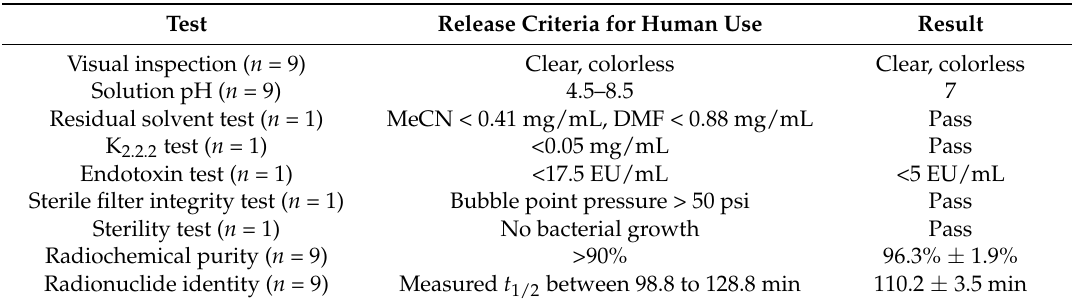
Table 1. Quality control results of [ 18 F]DHMT.